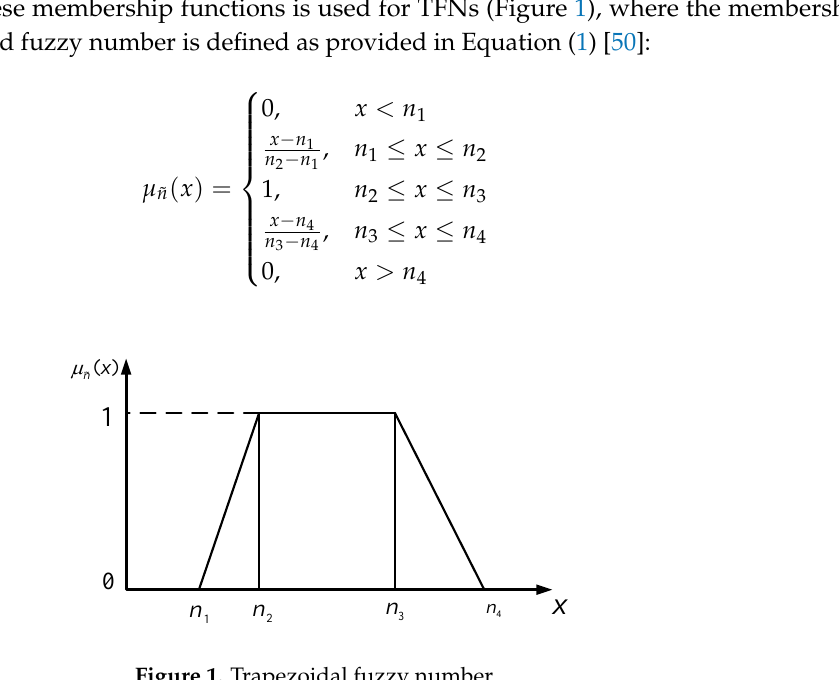
Figure 1. Trapezoidal fuzzy